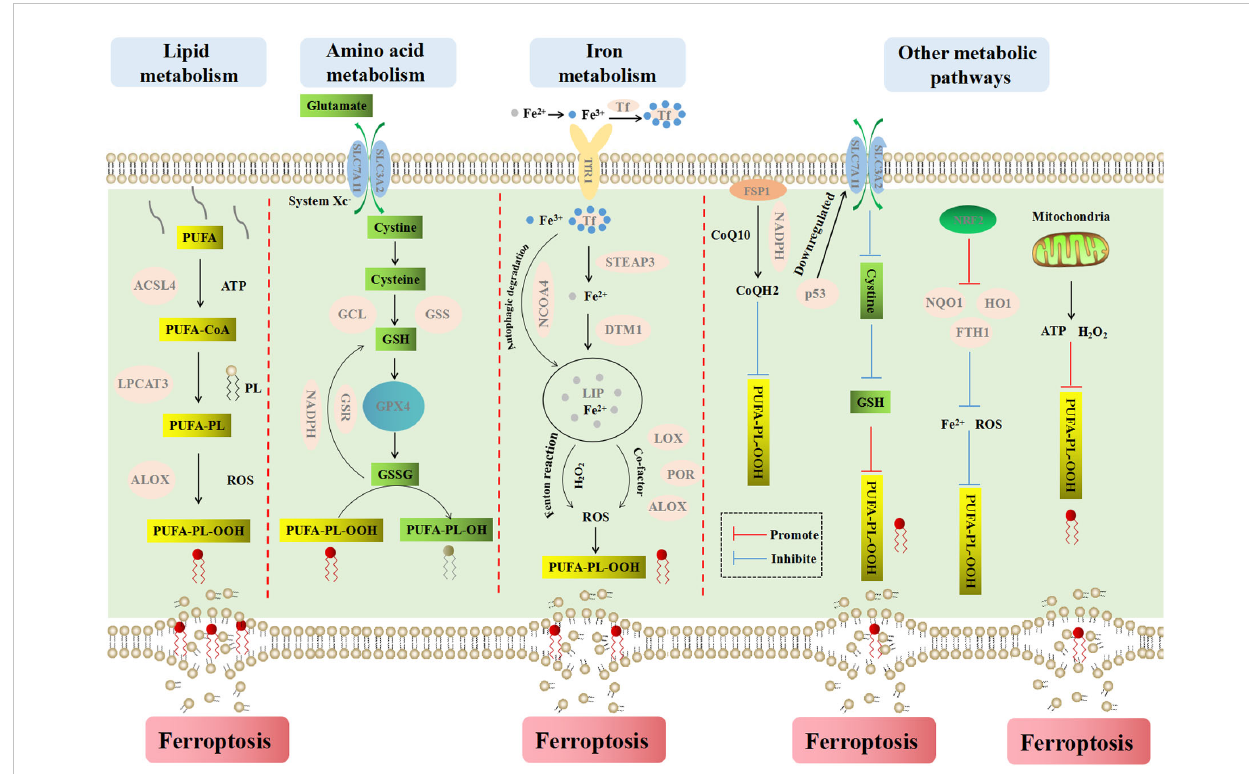
FIGURE 3 The main metabolic pathways and processes of ferroptosis. Ferroptosis is a iron-dependent cell death type, which causes cell membrane rupture by lipid peroxidesn. Lipid metabolism explains the formation process of lipid peroxides from PUFA to PUFA-PL-OOH. Amino acid metabolism explains the process of cell inhibiting lipid peroxidation by GSH. Iron metabolism explains the important role of iron ions for inducing ferroptosis. Fe 2+ reacts with endogenous H 2 O 2 in Fenton reaction to produce abundant ROS, which can promote lipid peroxidation and ferroptosis. Other metabolism ways mainly explain the in fl uence of FSP1, NADPH, CoQ10, p53, NRF2 and mitochondria on